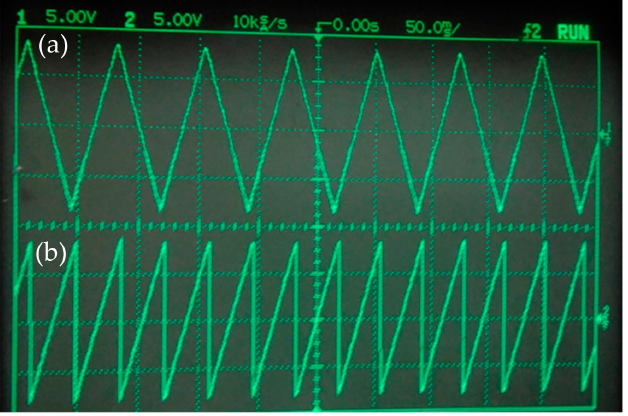
Figure 4. Waveforms of the DAC output signal: ( a ) triangular wave and ( b ) sawtooth wave.